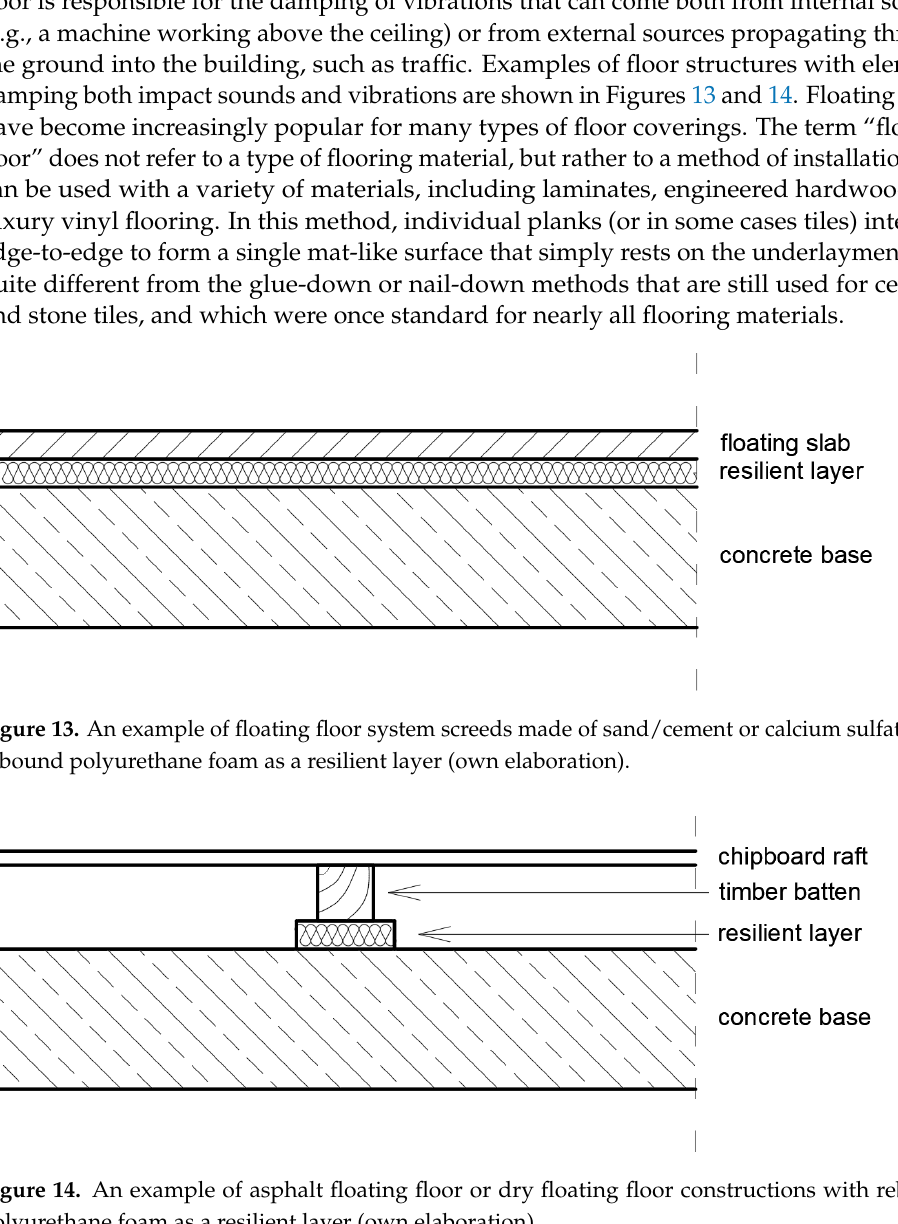
Figure 12. Acceleration frequency response spectrum of an example sample of Sylomer SR 11 12.5 mm polyurethane with indication of half-power frequency range (D = 9%) (own elaboration).